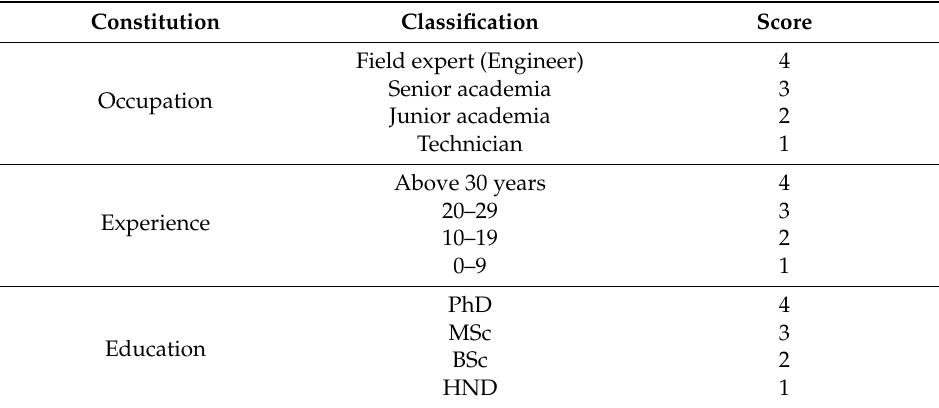
Figure 4. RPN values obtained from the traditional FMEA technique ( ∎ ) versus weighted RPN values obtained by the propose method ( ∎ ). Table 8. Weighting criteria for the group of